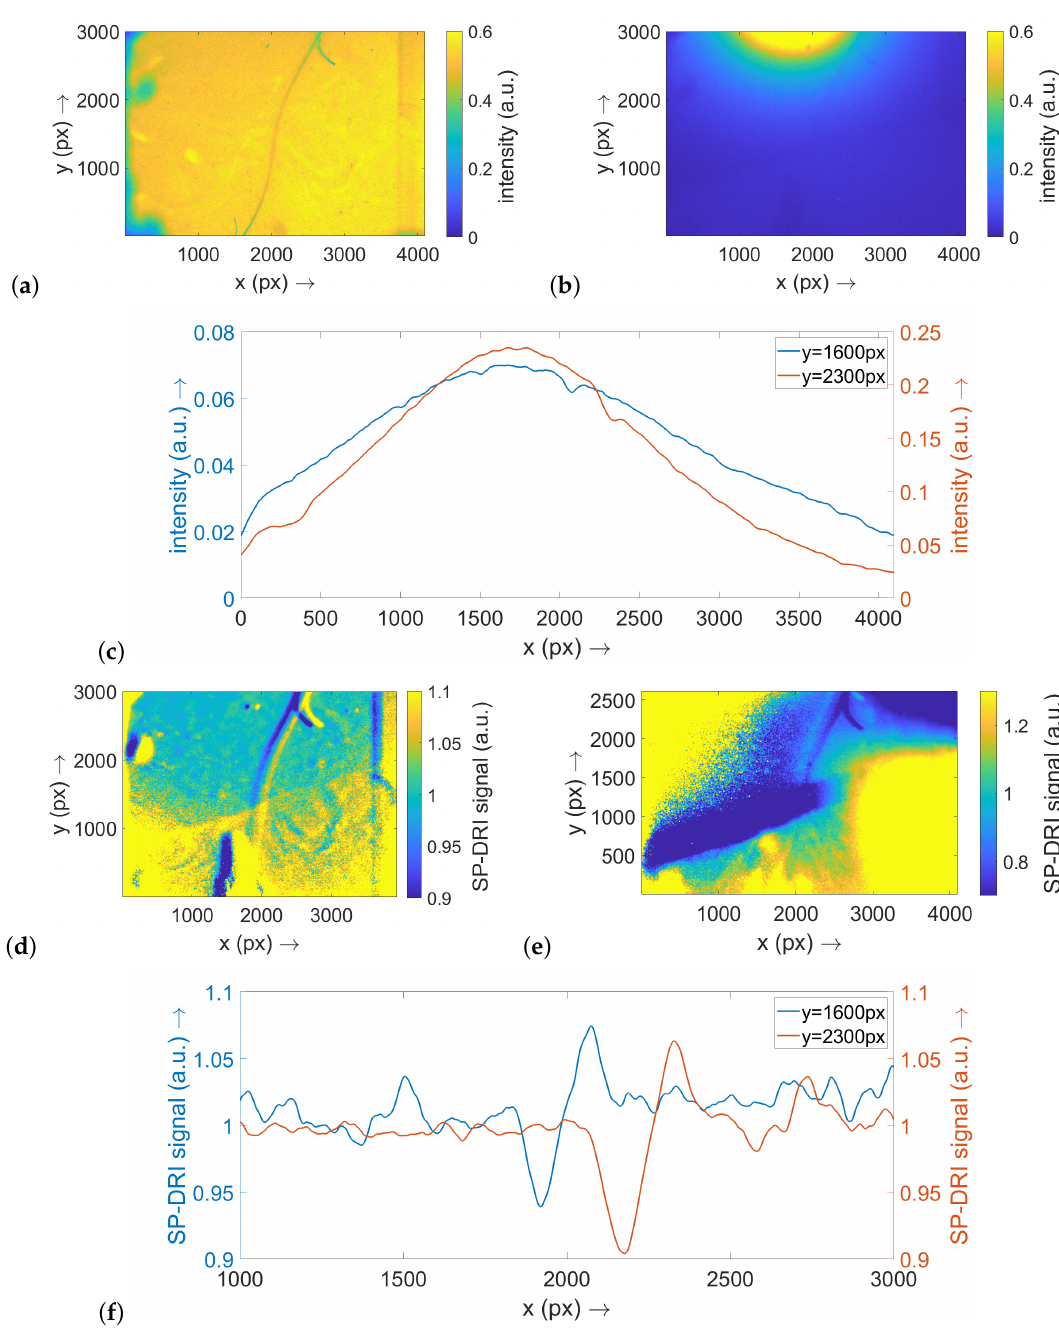
Figure 3. This figure shows the results for the optical phantom for the configuration with a thread of 10µm diameter. ( a ) Transmitted light image using a broadband light source; this image serves as reference for assessing the data reconstruction presented in the following subimages. ( b ) Exemplary diffuse reflectance raw data set when illuminating the optical phantom with LED #1. ( c ) Cross- sections along the x axis through the raw data map shown in ( b ) at the two y positions indicated. ( d ) SP-DRI reconstruction based on the diffuse reflectance matrices for the illumination with LED #1 and LED #2 (the matrix shift is thus along the x axis). ( e ) SP-DRI reconstruction based on the diffuse reflectance matrices for the illumination with LED #4 and LED #5 (the matrix shift is thus along the y axis). ( f ) Cross-sections along the x axis through the SP-DRI map shown in ( d ) at the two y positions indicated. Note: ( a – c ) are scaled to